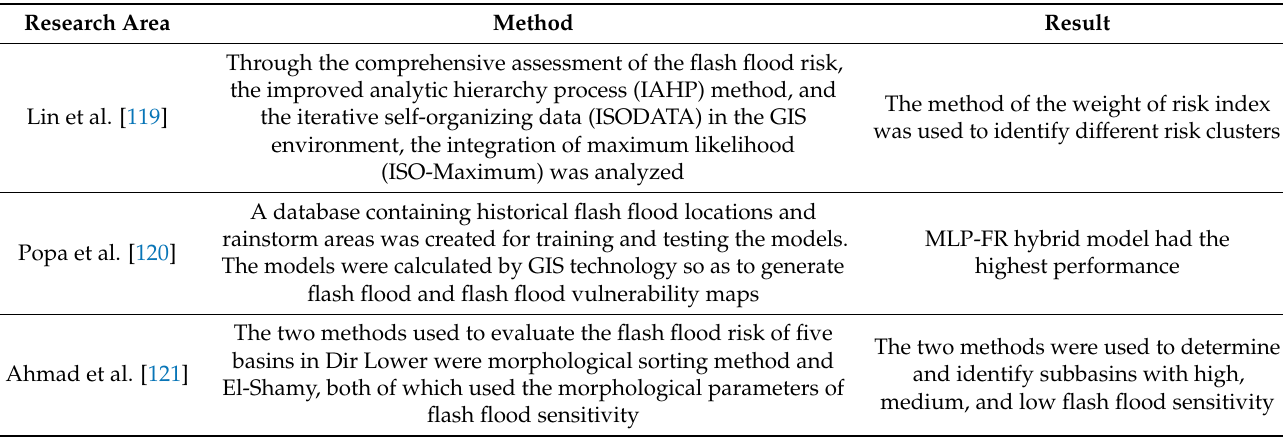
Table 6. Typical cases of risk